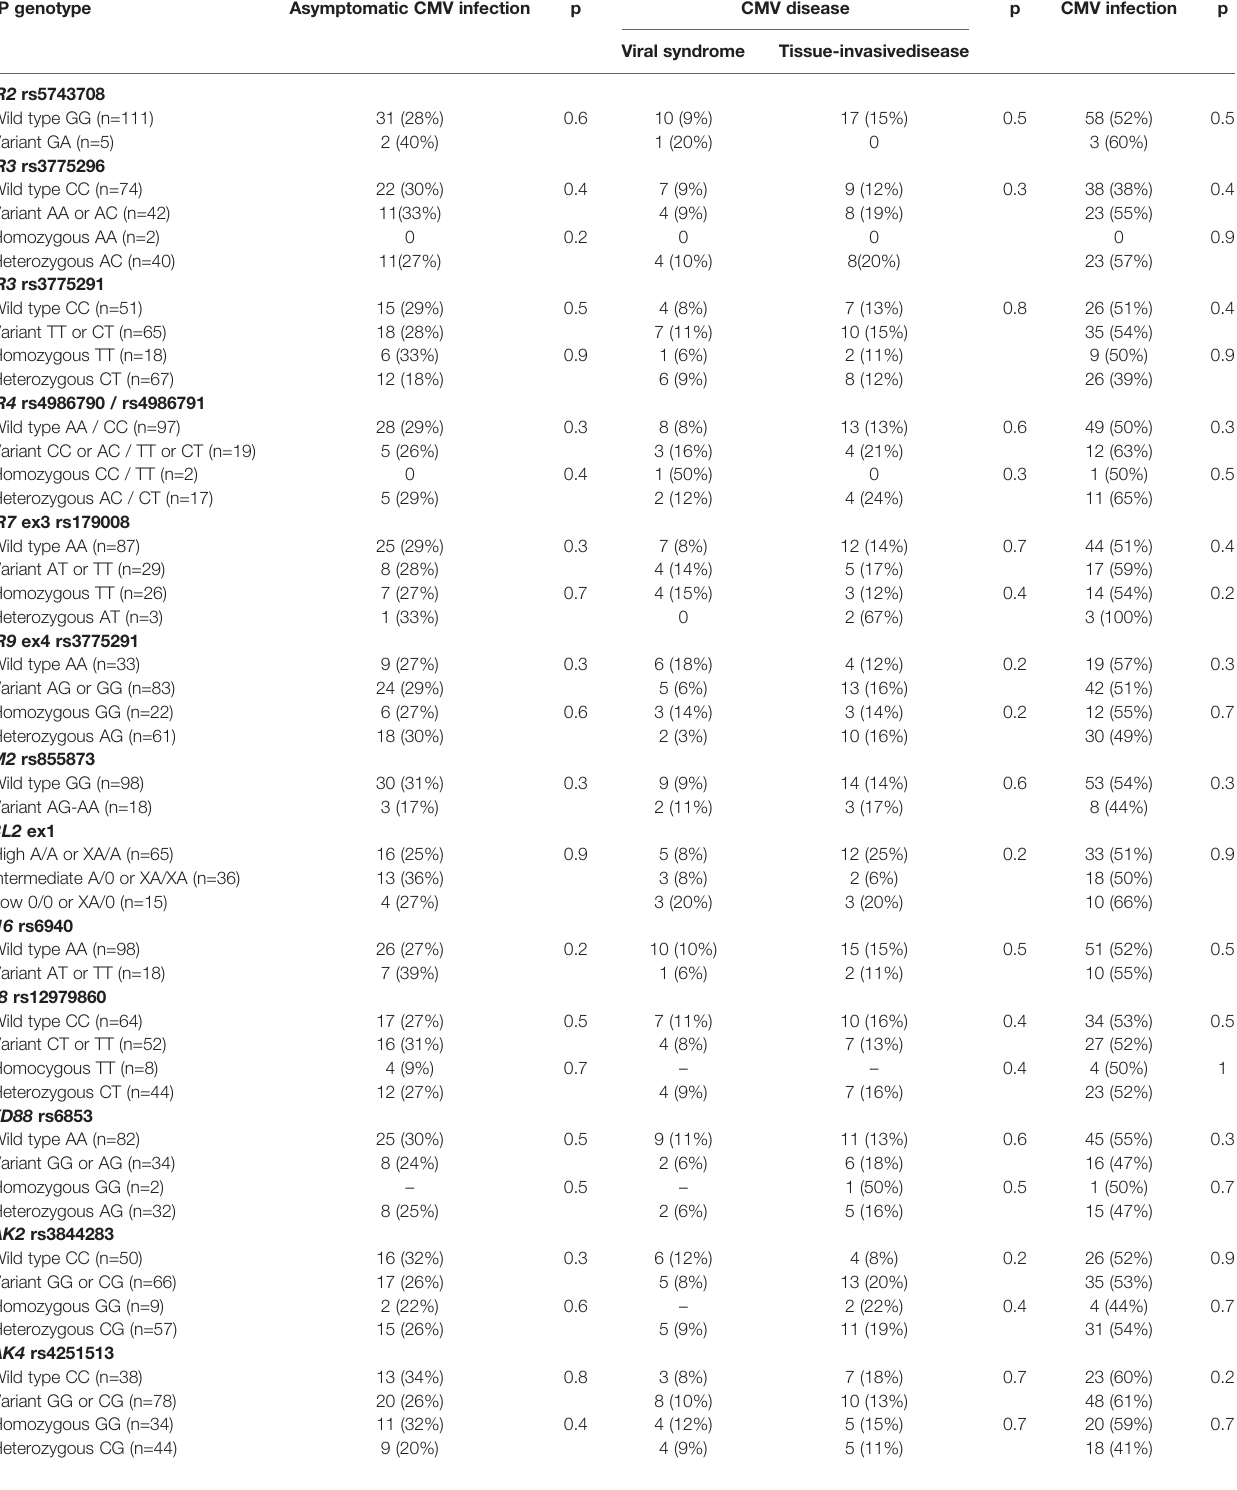
TABLE 2 | Univariate analysis of CMV infection according to TLR 2, 3, 4, 7, 9, AIM2, MBL2, IFI16, IL28B, MYD88, IRAK2 and 4